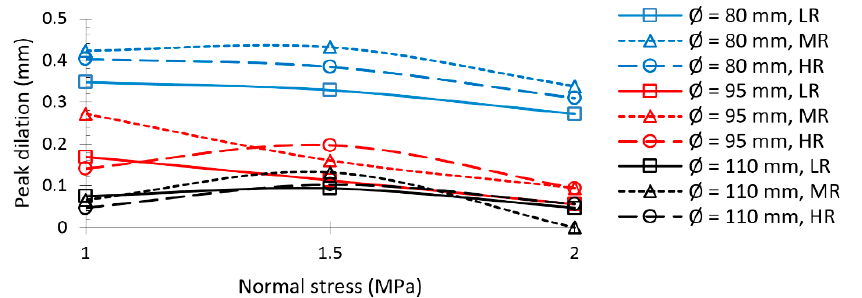
Figure 9. Peak dilation of J&Br specimens embedding a single joint with different sizes and roughness under different normal stress levels.